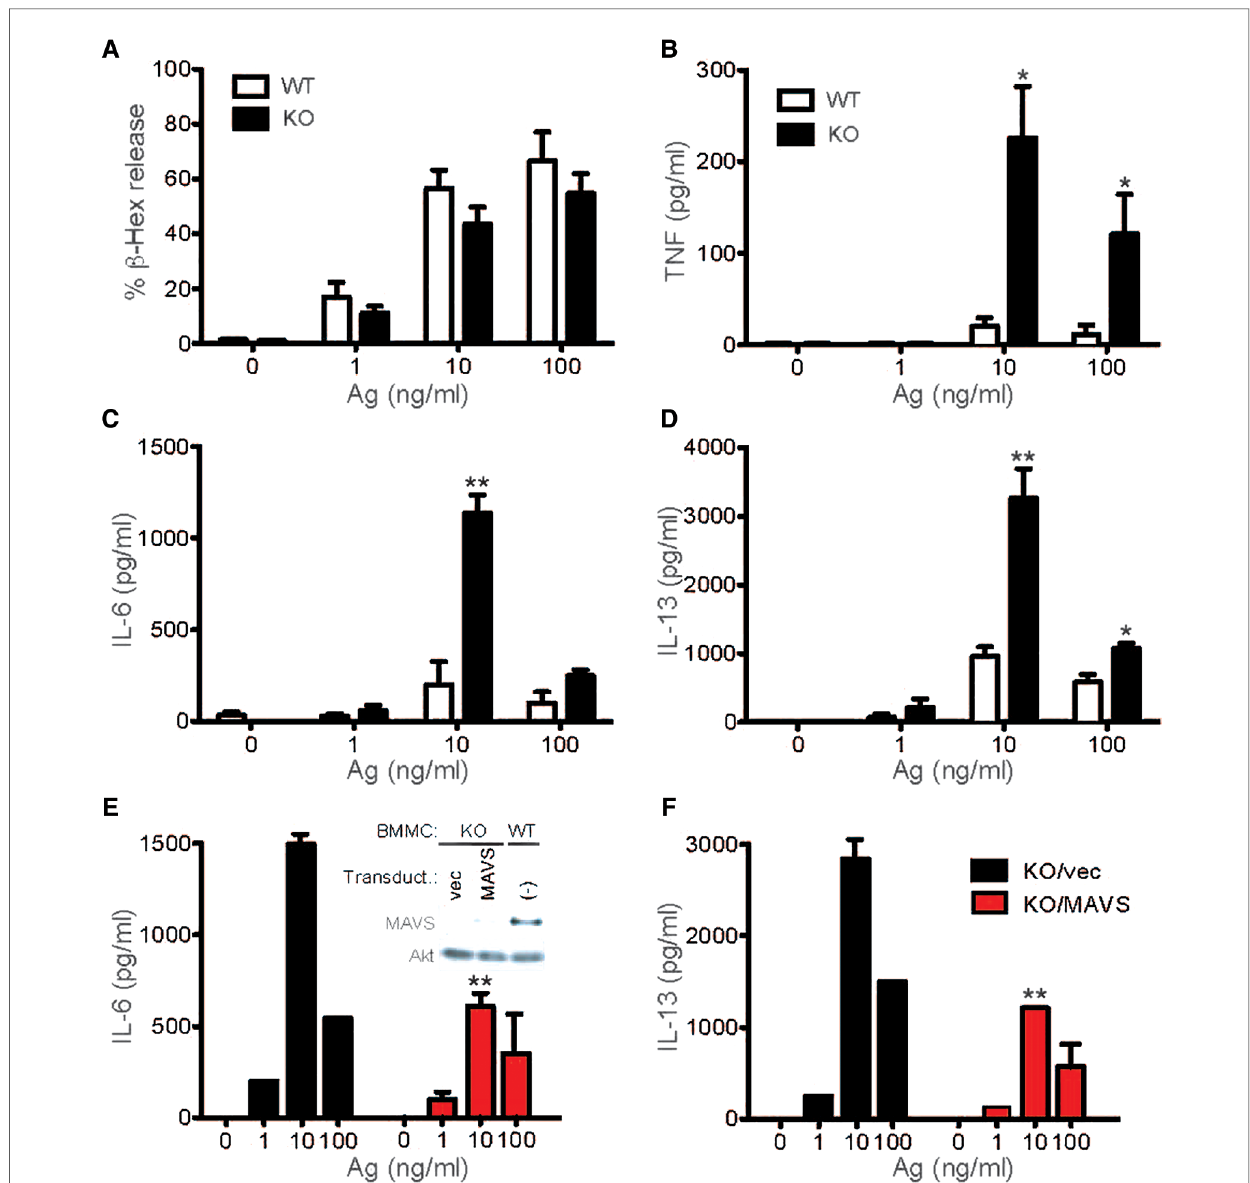
FIGURE 1 MAVS-de fi cient mast cells secrete increased cytokines upon Fc ϵ RI stimulation. ( A – D ) WT and MAVS − / − BMMCs were sensitized with anti-DNP IgE and stimulated with the indicated concentrations of DNP 23 -HSA (Ag) for 45 min (for β -hexosaminidase release) or 20 h (for secretion of cytokines). More than 5 independent experiments on Syk phosphorylation were performed by 3 different researchers with similar results. Ratios of phosphorylated Syk to Syk amount were calculated by densitometry ( A, Right ). ( E,F ) MAVS − / − BMMCs were infected with bicistronic retrovirus encoding MAVS or empty vector (vec). Puromycin-resistant cells were subjected to IgE sensitization and Ag stimulation. Inset in panel E shows expression of MAVS in MAVS − / − BMMCs and WT BMMCs along with Akt expression in these cells. Results from 3 transduction experiments are shown. Mean±SEM are shown. *, **: p <0.05, p <0.01 vs. WT cells ( B-D ) or empty vector-transduced cells ( E,F ) by Student ’ s t